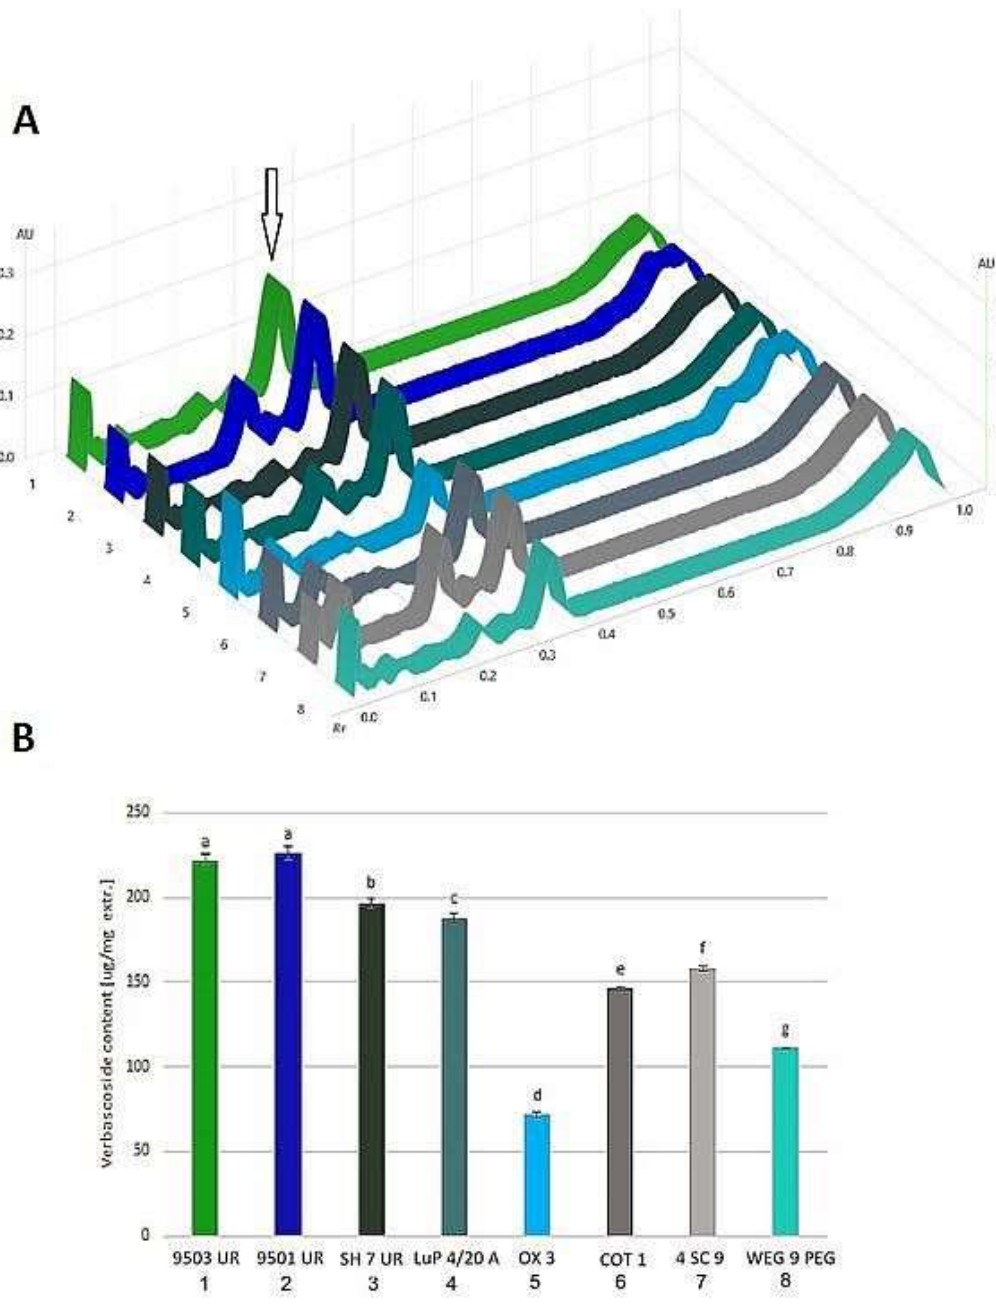
Figure 5. Verbascoside quantification in leaf blades dry extracts of chosen clones. ( A )—HPTLC polyphenolic profiles with marked verbascoside peak (R f = 0.33; arrow), ( B )—calculated verbascoside content [μg/mg of dry extract]. Means marked with the same letters do not differ significantly ( p < 0.05). R f – retention factor.